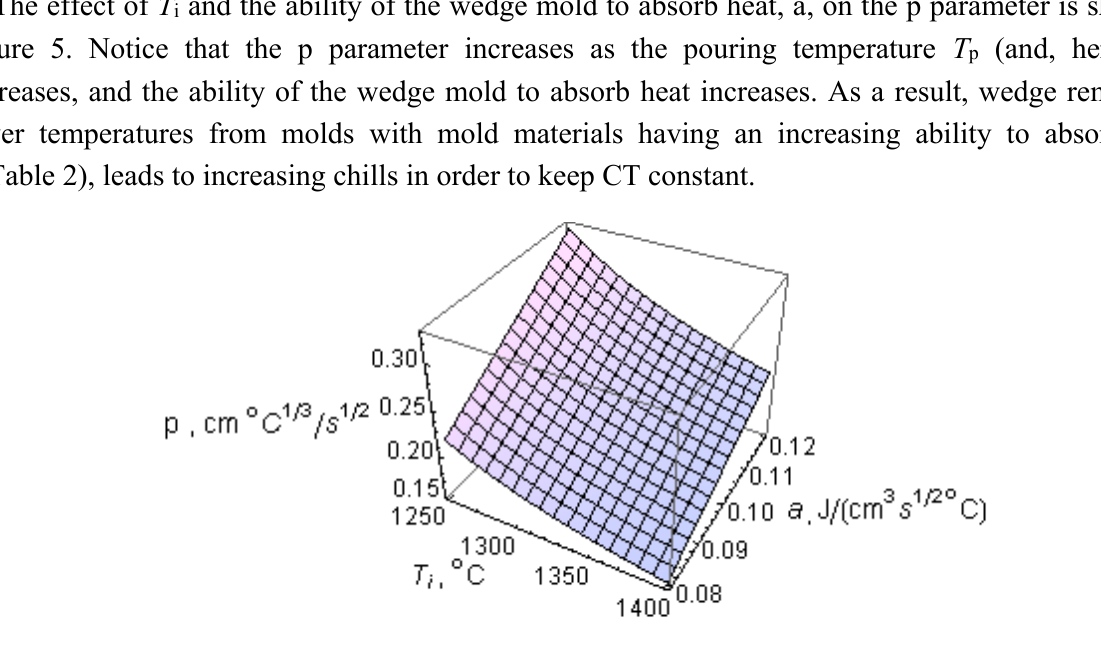
Figure 5. Effect of initial liquid metal temperature just after pouring into the mold, T i , and the ability of the mold to absorb heat, a, on the p parameter. Table 2. Reported a values for mold materials